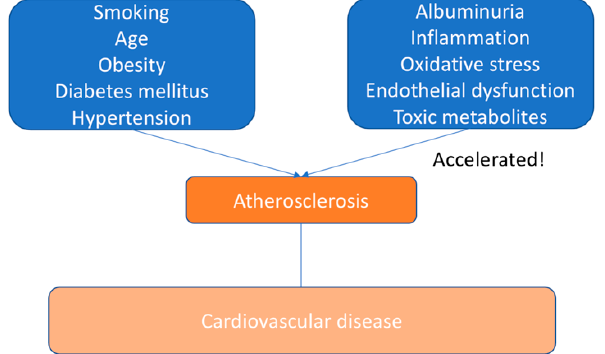
Figure 2. Additional risk factors related to CKD, which lead to atherosclerosis development.